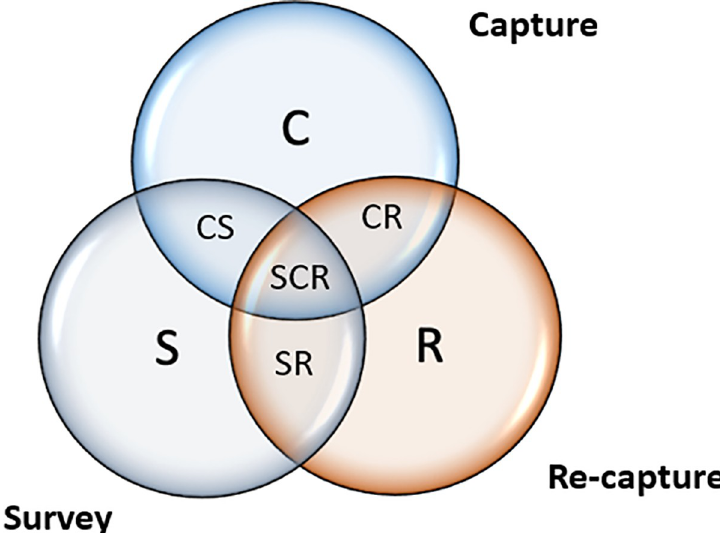
Fig 1. Framework used to obtain population size estimates for roamer FSWs using 3-source capture-recapture approach.